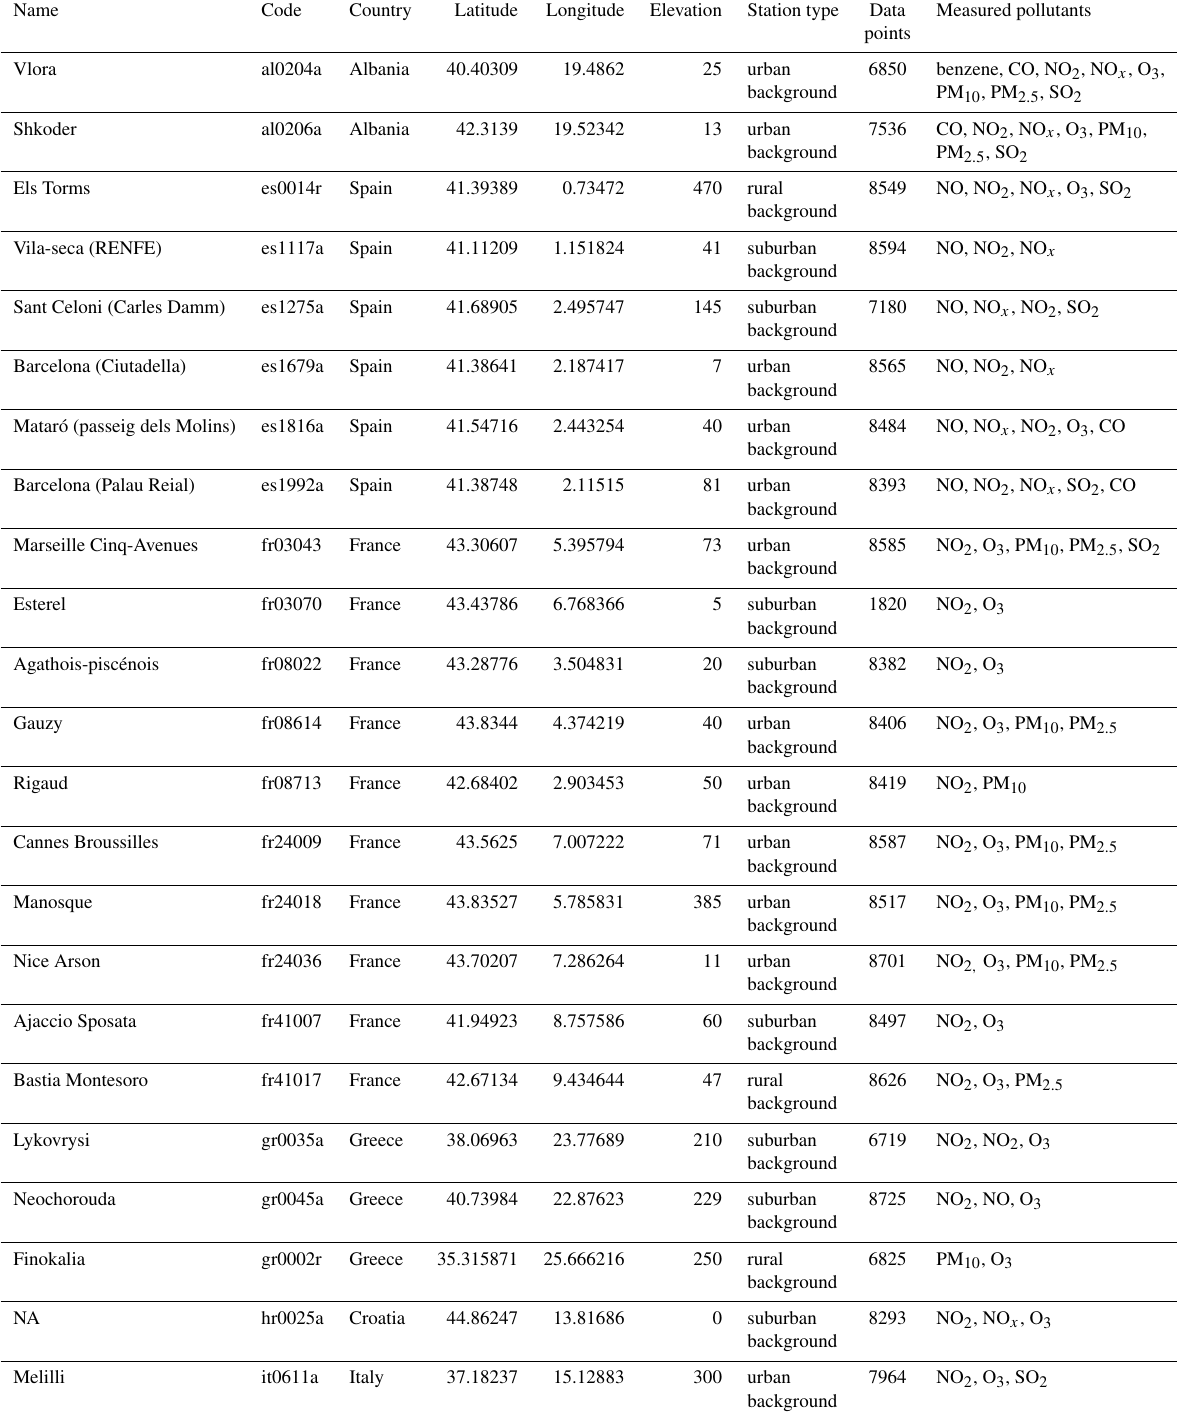
Table B1. Detailed overview of monitoring